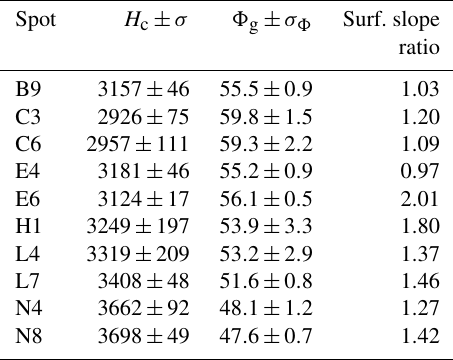
Table 1. Physical parameters, observed (critical thickness H c ± 1 σ (m); ratio of the local surface slope to regional surface slope (ICE- Sat)) and inverted (GF (cid:56) g ± 1 σ (cid:56) , mWm − 2 ). The surface slopes are computed in circles with a 3km and 10km radius centred on each spot, onto which the surface DEM (Bamber et al., 2009) is fit- ted by a biquadratic function. The ratio between the two slopes is presented below for each spot. A ratio > 1 corresponds to a slope locally steeper than its environment.